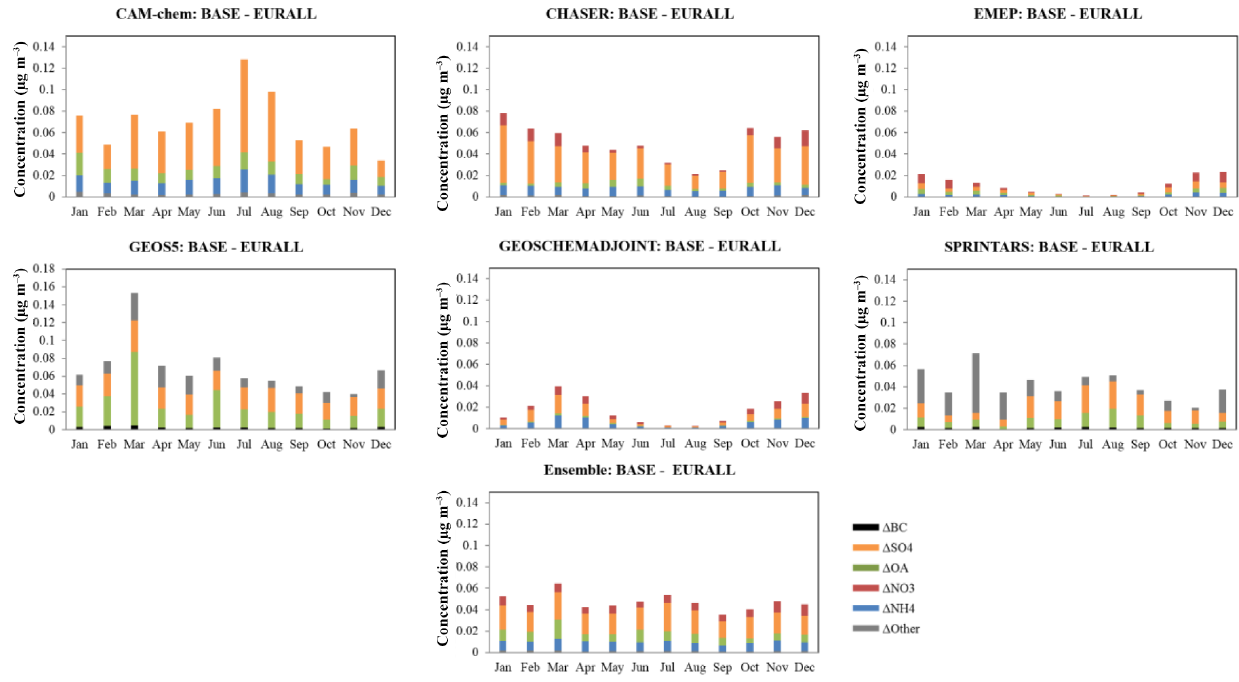
Figure 5. Monthly averages of surface aerosol response in the EAS receptor region under the EURALL scenario. Solid bars with different colors represent the responses of different